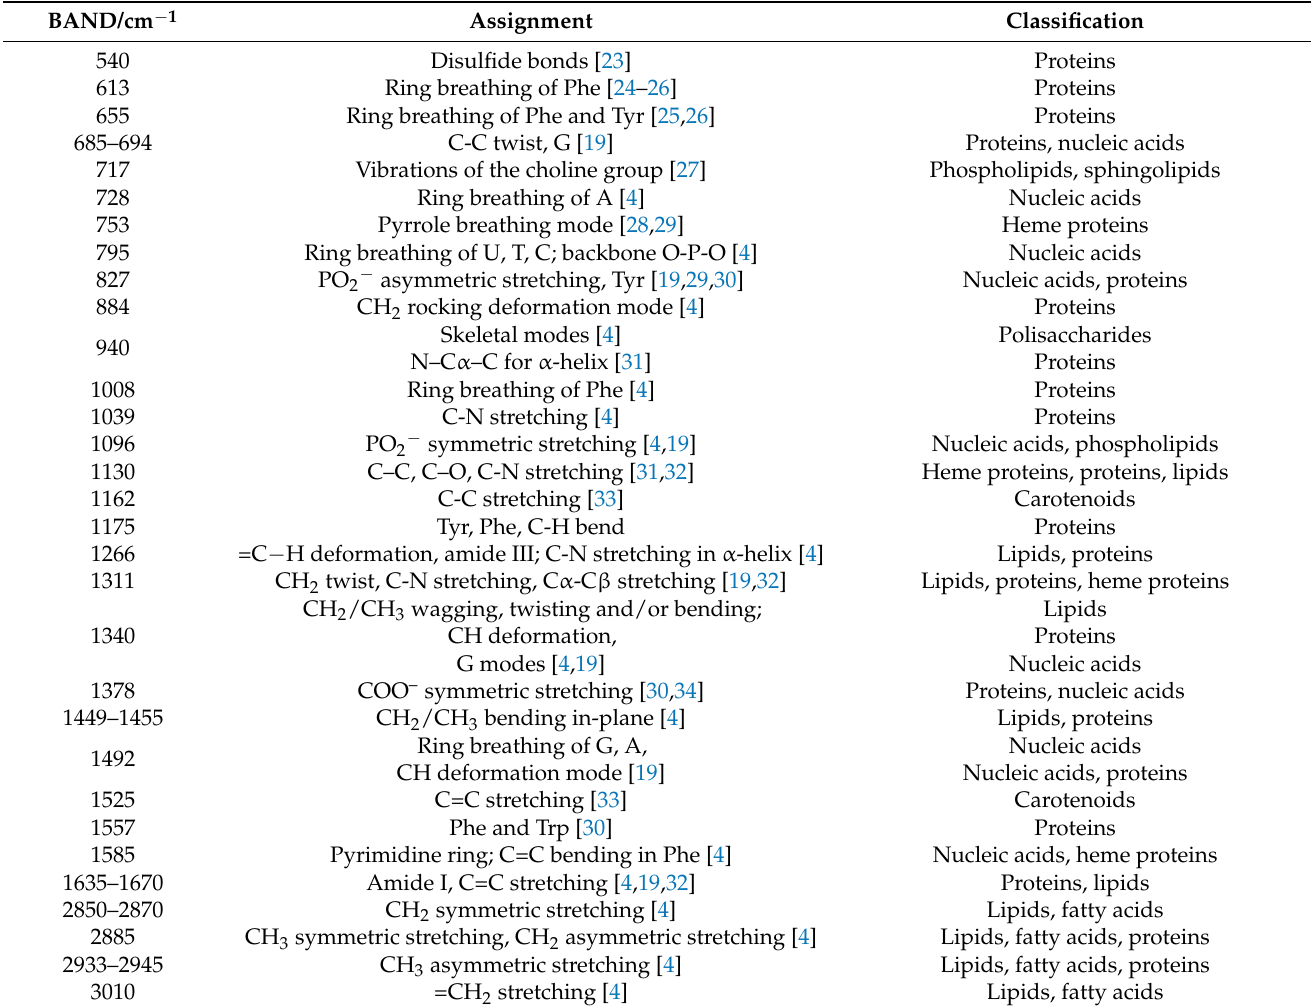
Table 1. Assignments of the Raman bands in the spectra of studied samples.